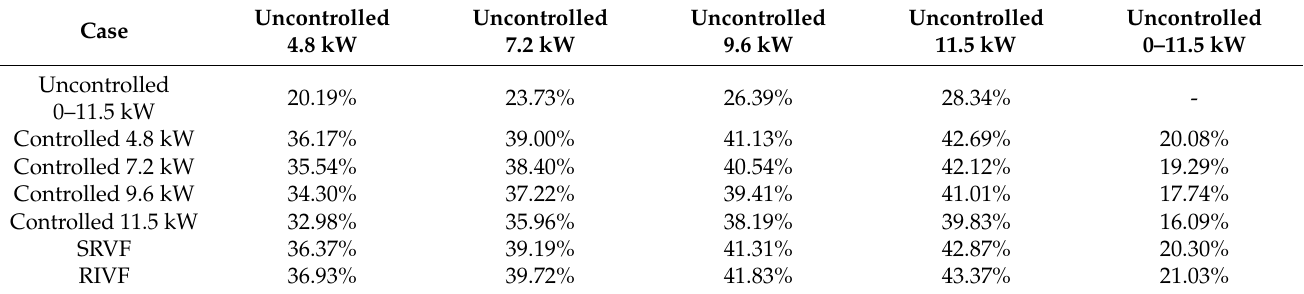
Table 7. Uncontrolled vs-controlled average load during charging percent